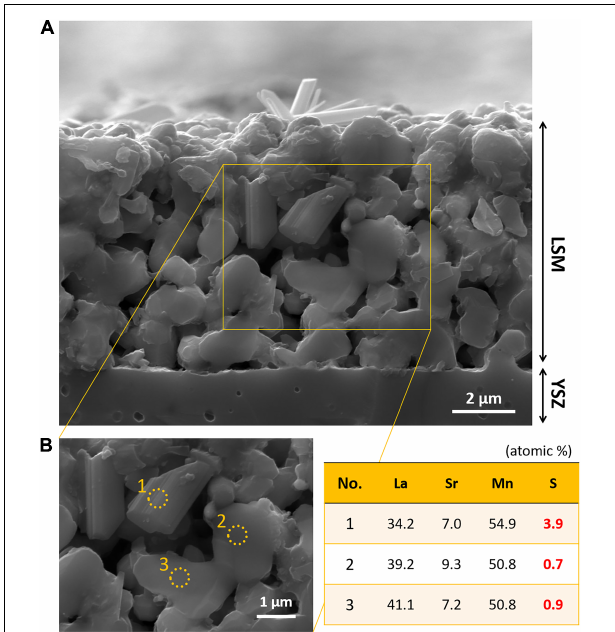
FIGURE 8 | (A) SEM image of the cross section of the LSM/YSZ cell exposed to an alternating atmosphere of air and 4 ppm SO 2 ( g ) for ∼ 530 h at 700 ◦ C during the electrochemical test. (B) Elemental composition (La, Sr, Mn, and S) of LSM particles measured by EDS (on the core and